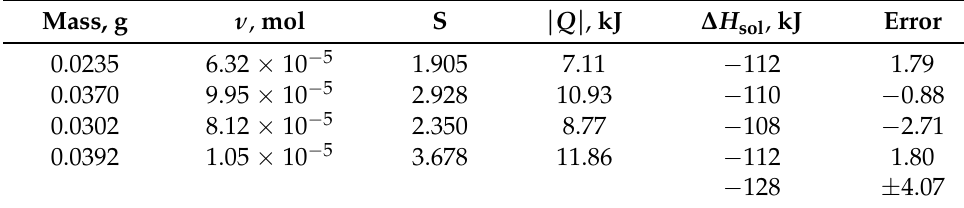
Table A3. Details of the ∆ H sol ( MgCl